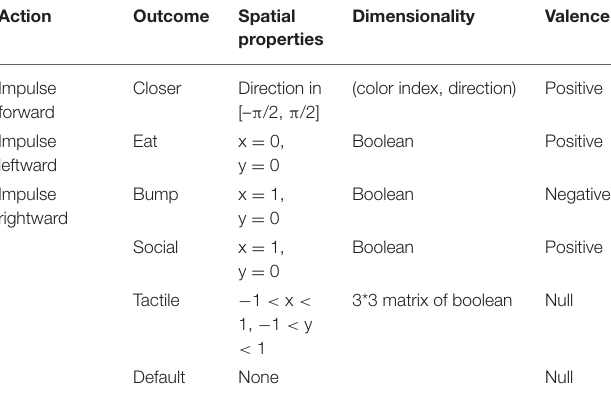
TABLE 1 | Actions and outcome.